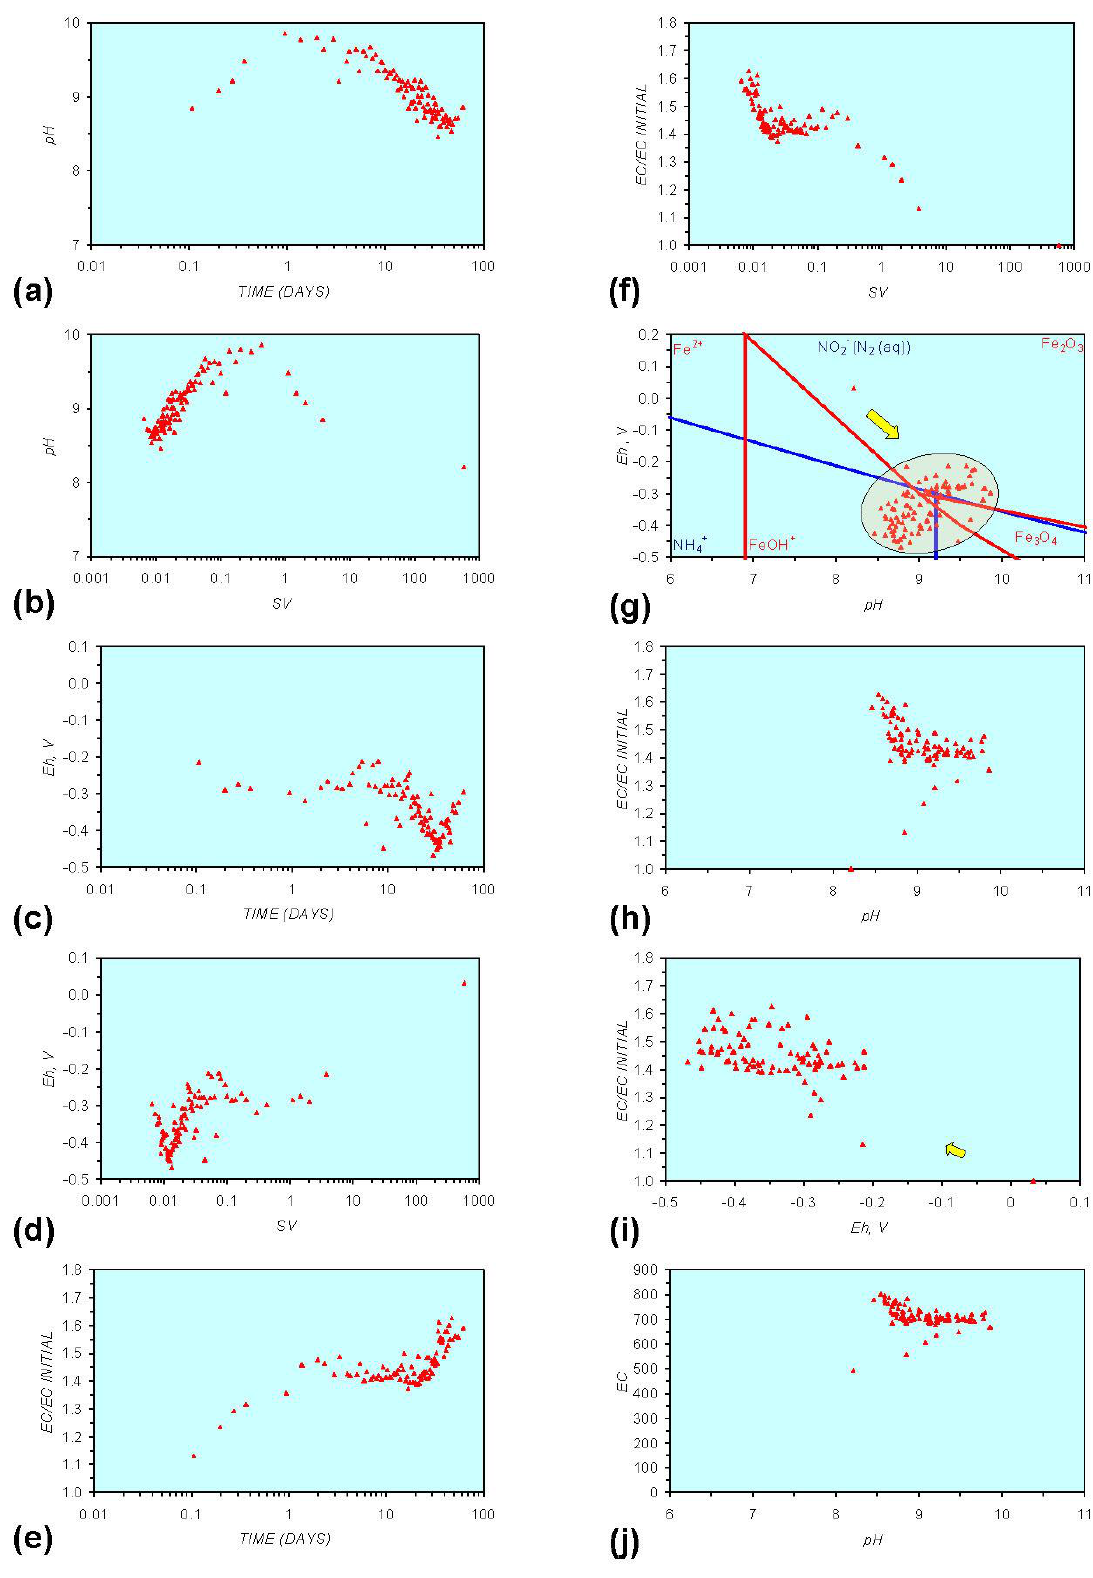
Figure A11. MR11: Ca-montmorillonite + n-Fe 0 + n-Cu 0 + n-Al 0 , fresh water. (a) pH vs. Time; (b) pH vs. SV; (c) Eh vs. time; (d) Eh vs. SV; (e) EC/EC Initial vs. time; (f) EC/EC Initial vs. SV; (g) Eh vs. pH (SRE ringed); (h) pH vs. EC/EC Initial; (i) Eh vs. EC/EC Initial; (j) pH vs. E(C) Arrows indicate decreasing SV and increasing